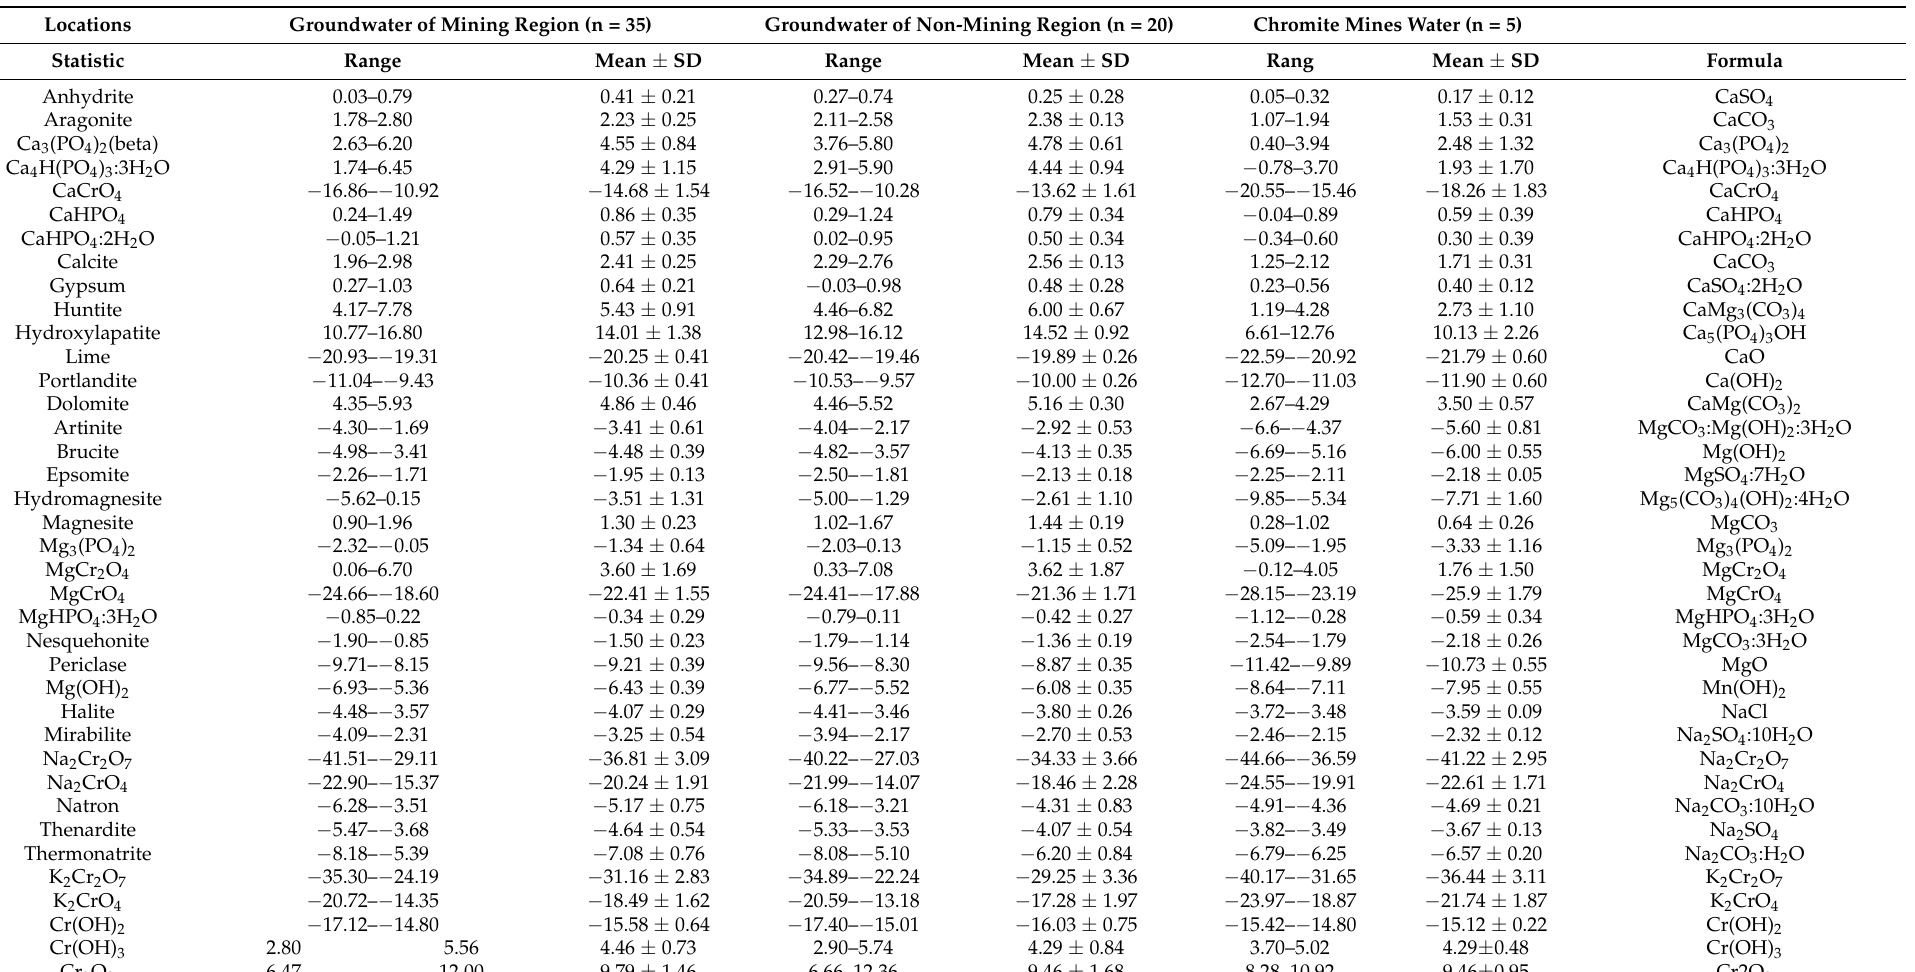
Table 5. Description of mineral phases of groundwater in the mining and non-mining regions and their comparison with chromite mines water in the ultramafic terrain of Malakand, Northern